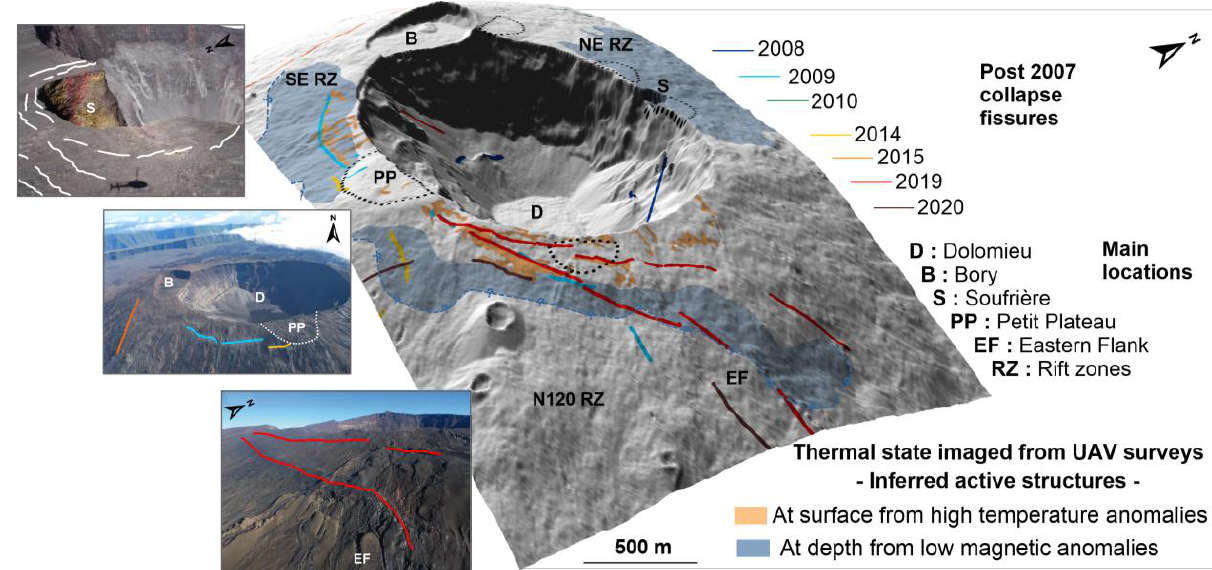
Figure 4: Combined interpretation from IR temperature and magnetic anomalies imaging. Fissures location from OVPF database (same color code as lava flows in Figure 1). Associated aerial field photos from OVPF-IPGP-Imaz Press.